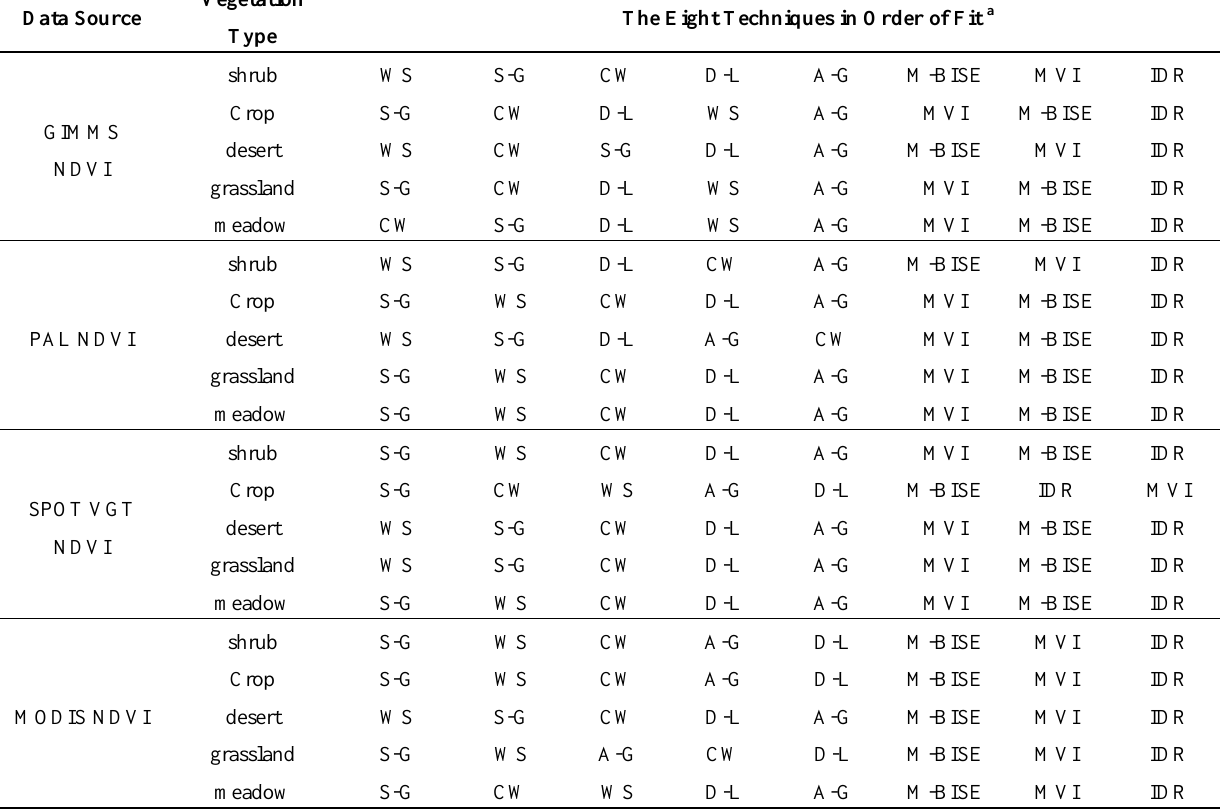
Table 7. Performance orders of the eight techniques for different data sources in terms of RMSE, AIC, and